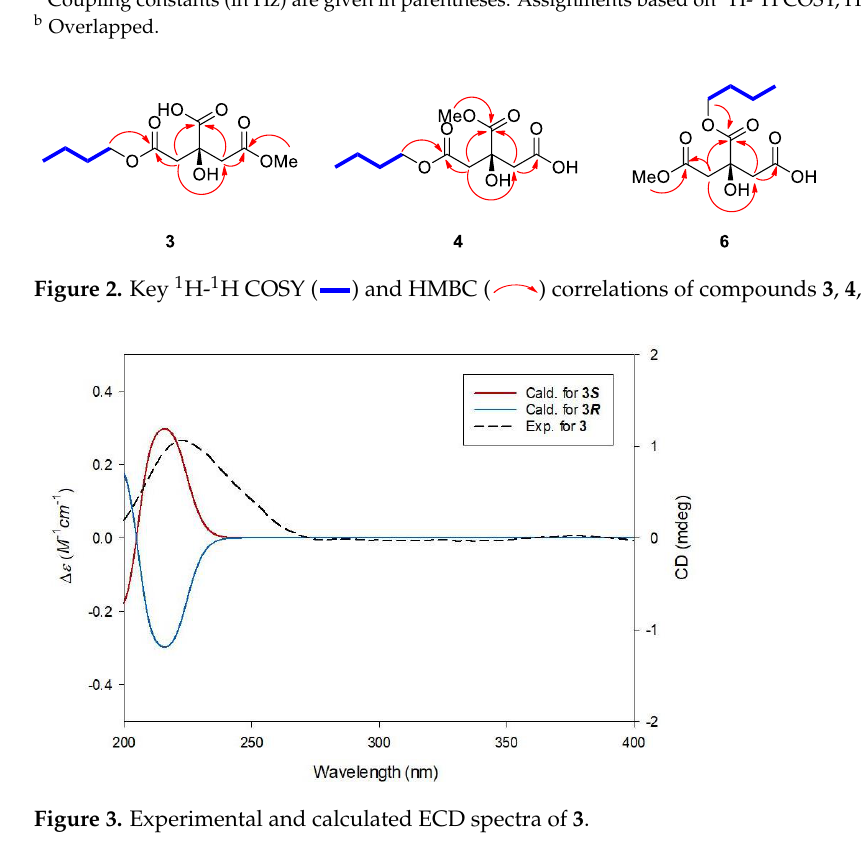
Figure 3. Experimental and calculated ECD spectra of 3 .